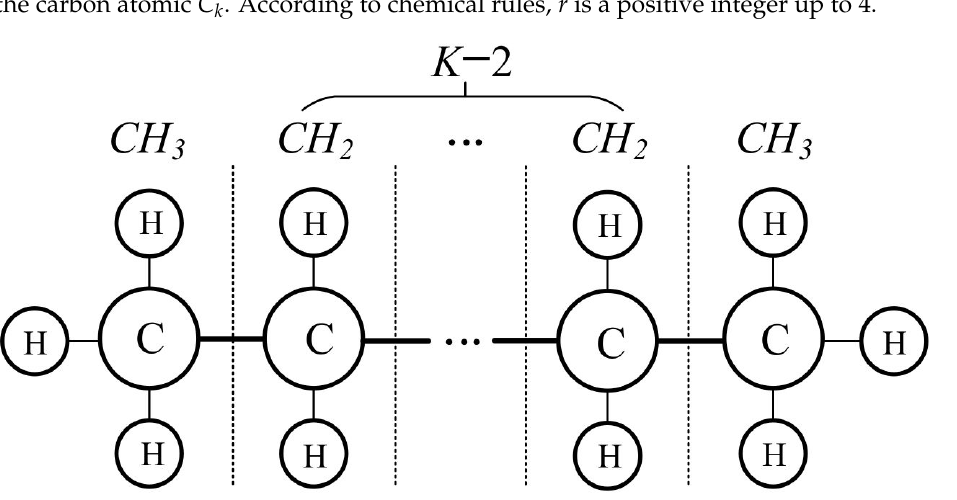
Figure 1. Common graph structure of an